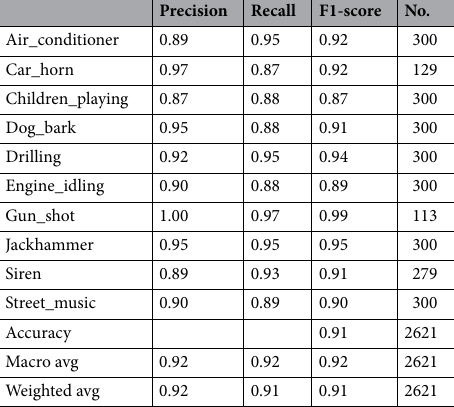
Precision Recall F1-score